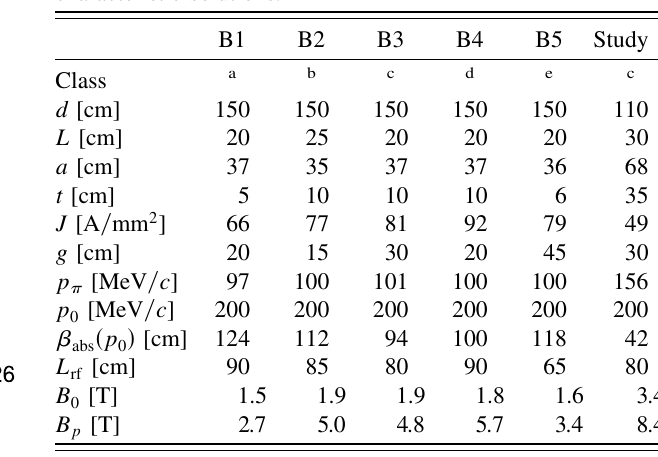
TABLE IV. Summary of the two-cell high-energy passband characteristic solutions.